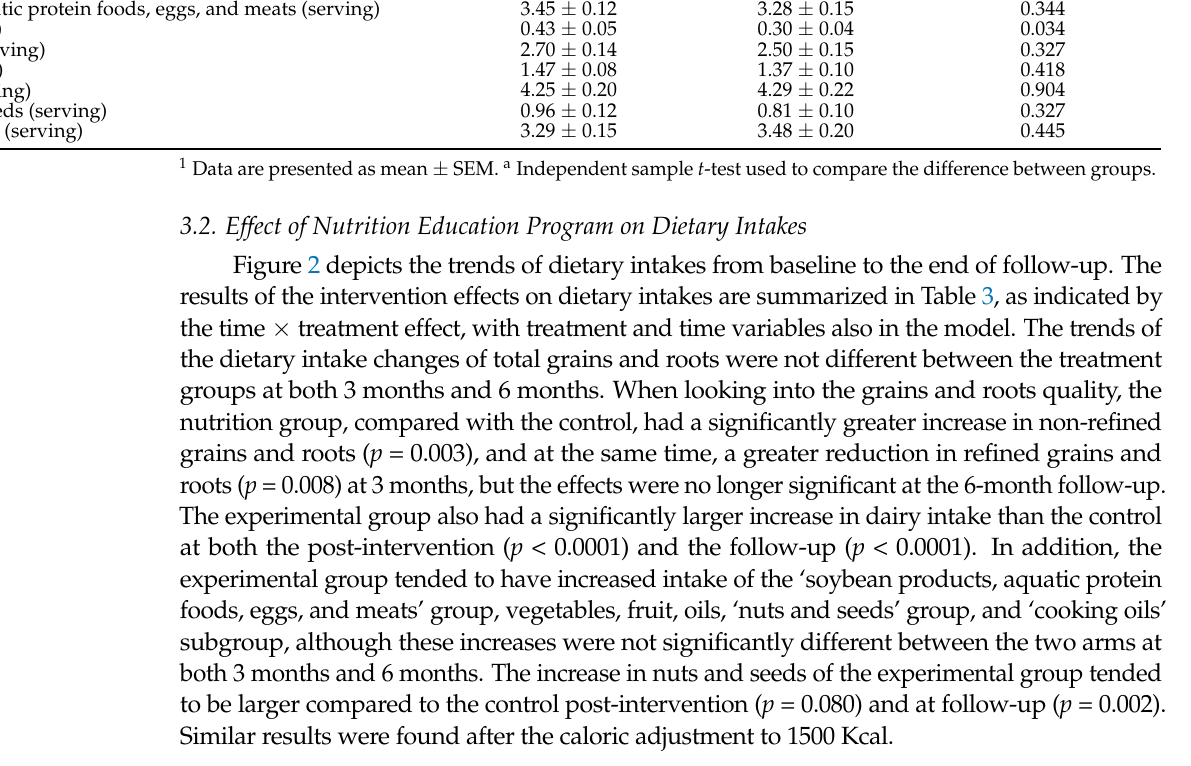
Table 3. Effect of nutrition education program on dietary intakes 1